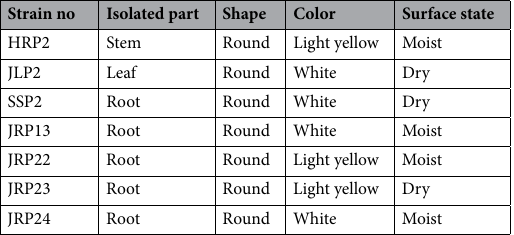
Table 2. Colony characteristics of phosphate solubilizing bacteria grown in PVK medium.